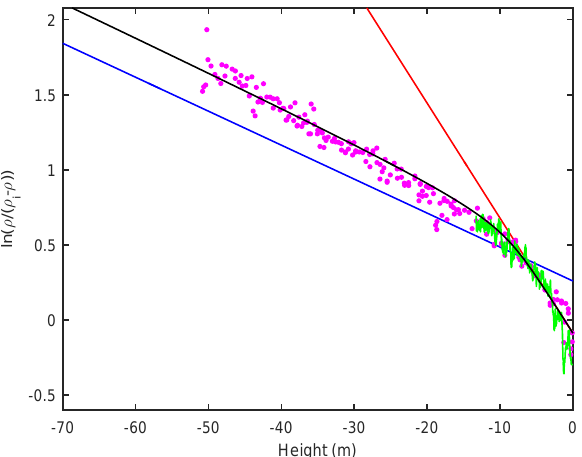
Figure 7. Profiles of ln( ρ / ( ρ i − ρ )) for iSTAR Site 4. Measured values from ice cores (magenta dots) and neutron-probe profiles (green), modelled values using Herron and Langway Stage 1 (red) and Stage 2 (blue) densification rates and modelled values using the transition model with ρ T = 580 kg m − 3 , M = 7 (black line). Table 2. Cost functions over the range 500–800 kg m − 3 for the Herron and Langway, Ligtenberg, and transition models for sites in the Pine Island Glacier basin. ¯ a Herron and Langway Ligtenberg Site